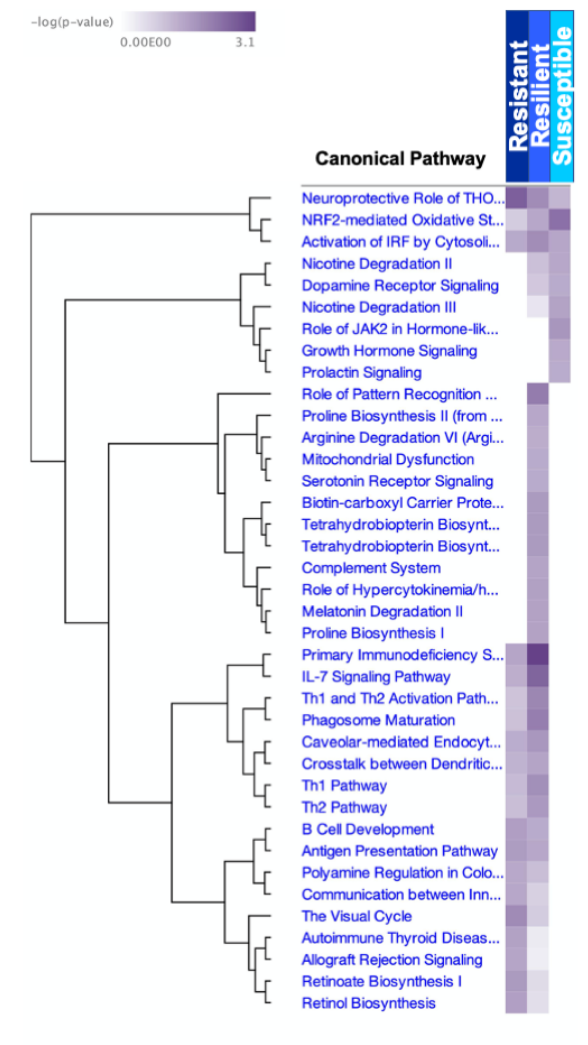
Figure 3. Significant Canonical Pathways are listed for each response group. The significance of each pathway to each response group is shown as –log ( p -value), with darker shading indicating greater